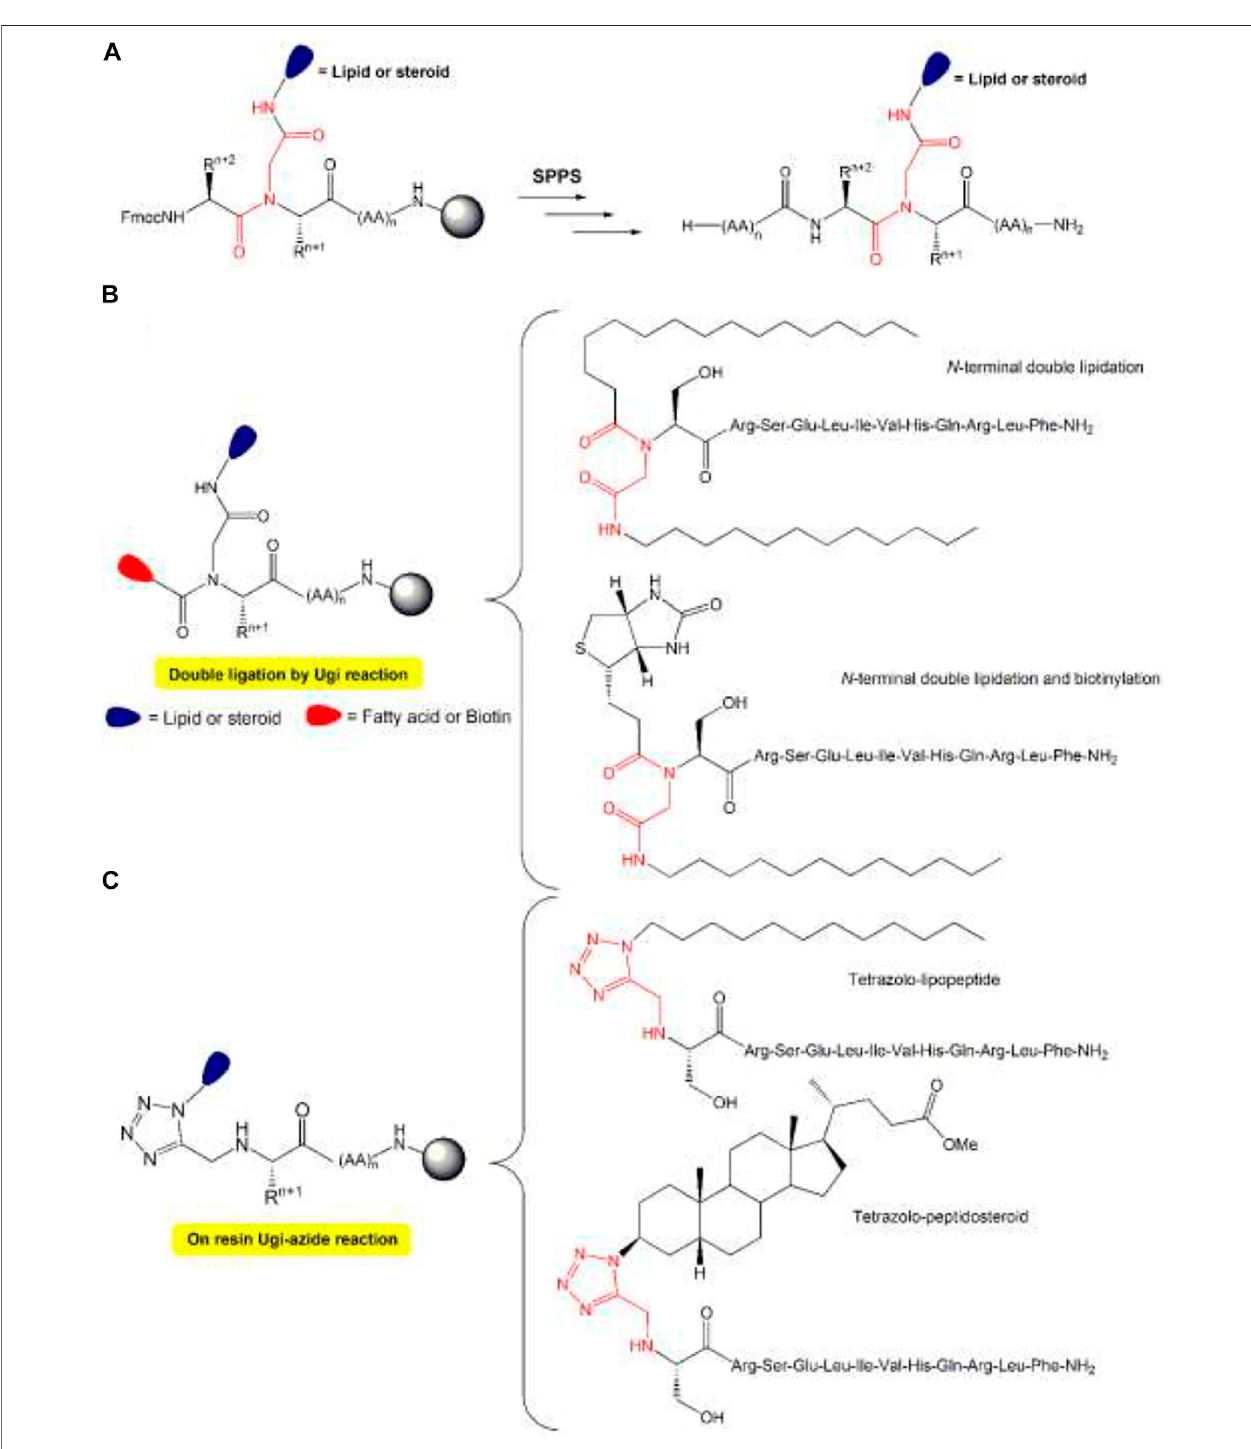
FIGURE 12 | Peptide-steroid and peptide-lipid conjugates. (A) Solid phase ligation (SPL) of lipids and steroids by resin-bound peptide (RBP) using on-resin Ugi reaction, (B) doubleligationbyUgireaction, (C) SPLoflipids,biotinylatedsteroidsbyRBPusingon-resinUgiazidereaction.Themostimportantcovalentbondbetween entities is highlighted in